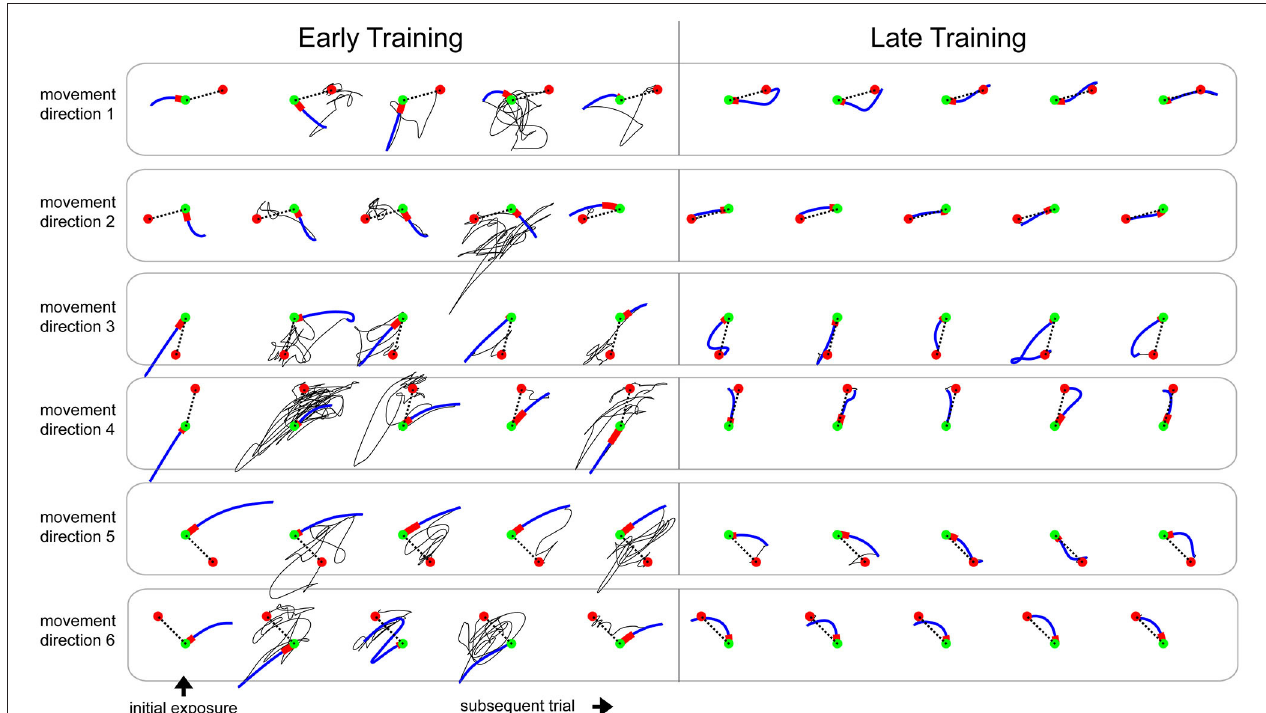
FIGURE 3 | Representative examples of movement paths from a subject practicing the learning task 3 with EA{gain 1, offset 0}. Green and red circles represent the start and target positions for the movements (15cm apart). The dotted black line is the ideal straight line. Blue segment is the initial launch of the movement, and red segment is the first 150ms of the initial launch. Solid Black line is the feedback correction phase of the movement where the subject navigated to the target after the initial launch. Note that the feedback correction phase is highly random during the early training and is greatly reduced and systematic during the late